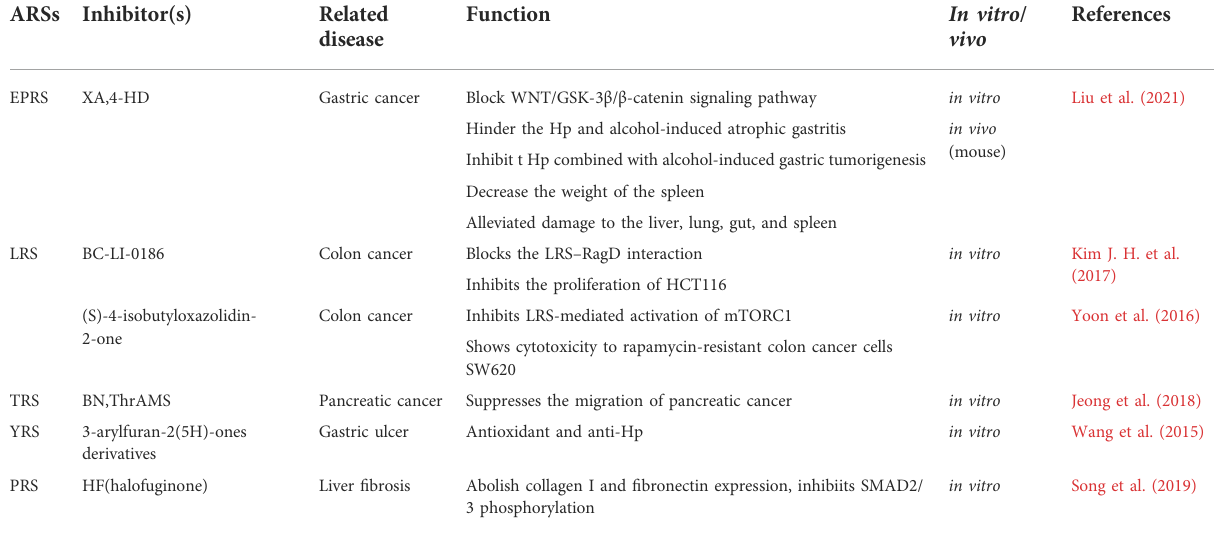
TABLE 2 ARSs related inhibitors and their effect in the digestive